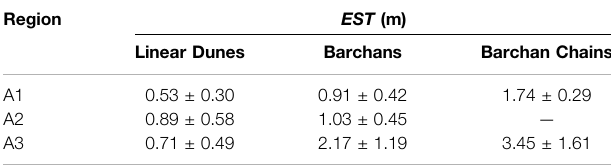
TABLE 3 | The equivalent sand thickness ( EST ) for the different dune types. Region